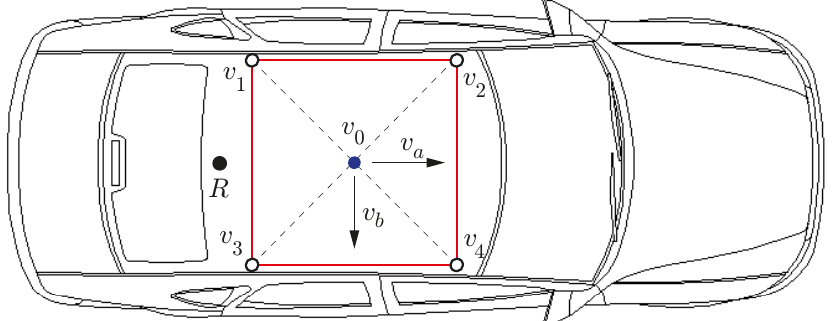
Figure 4. Placement of the antennas on the roof of a